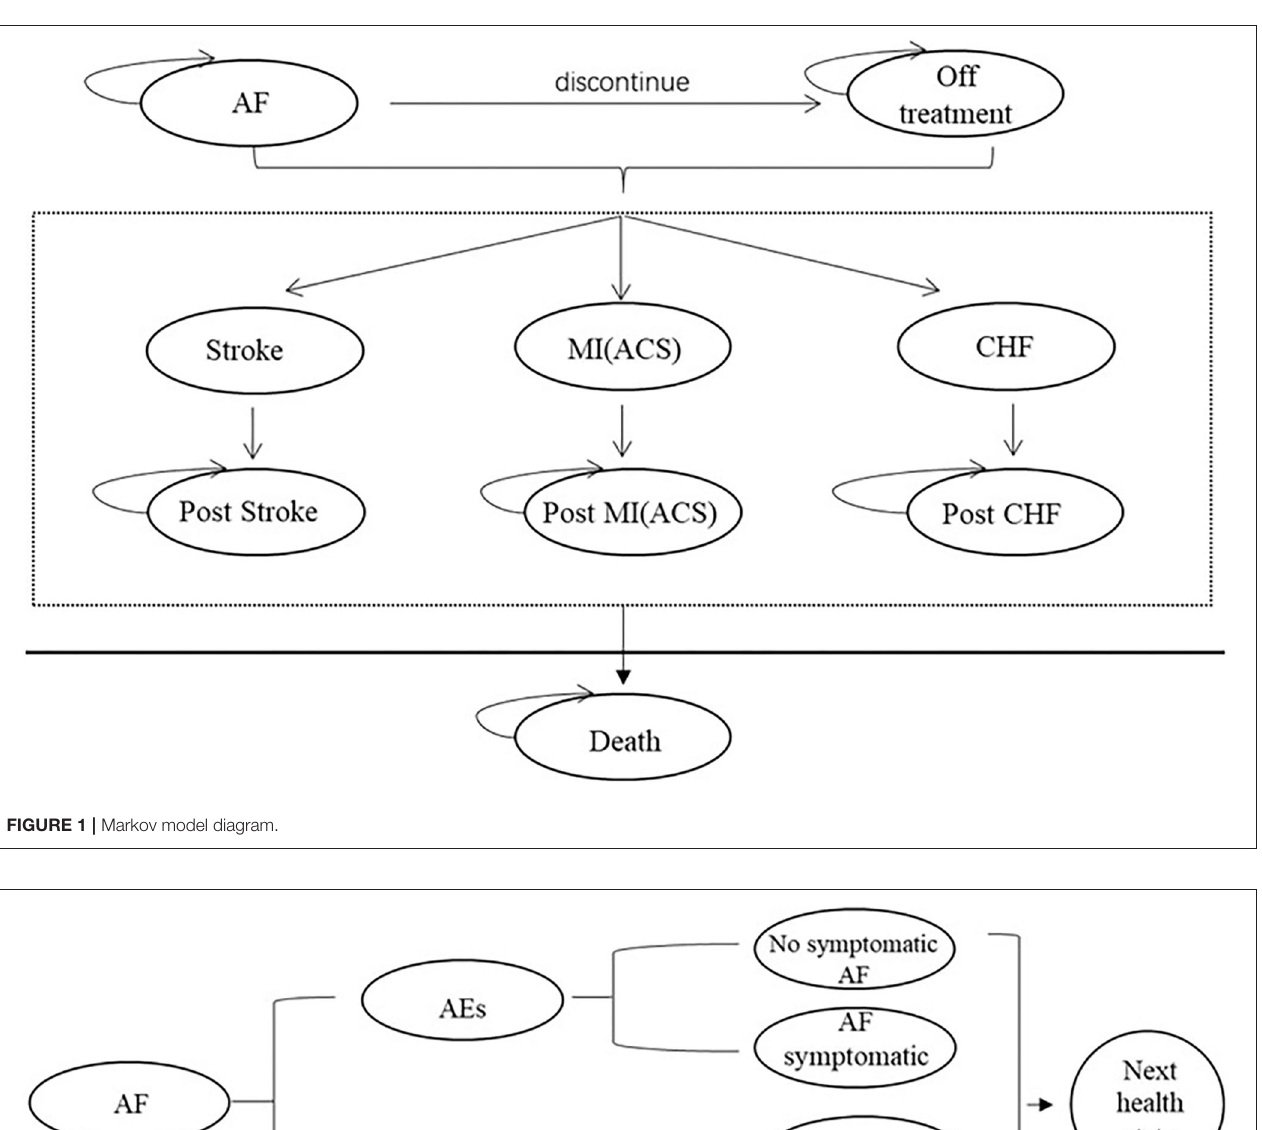
FIGURE 2 | Cycle path within the